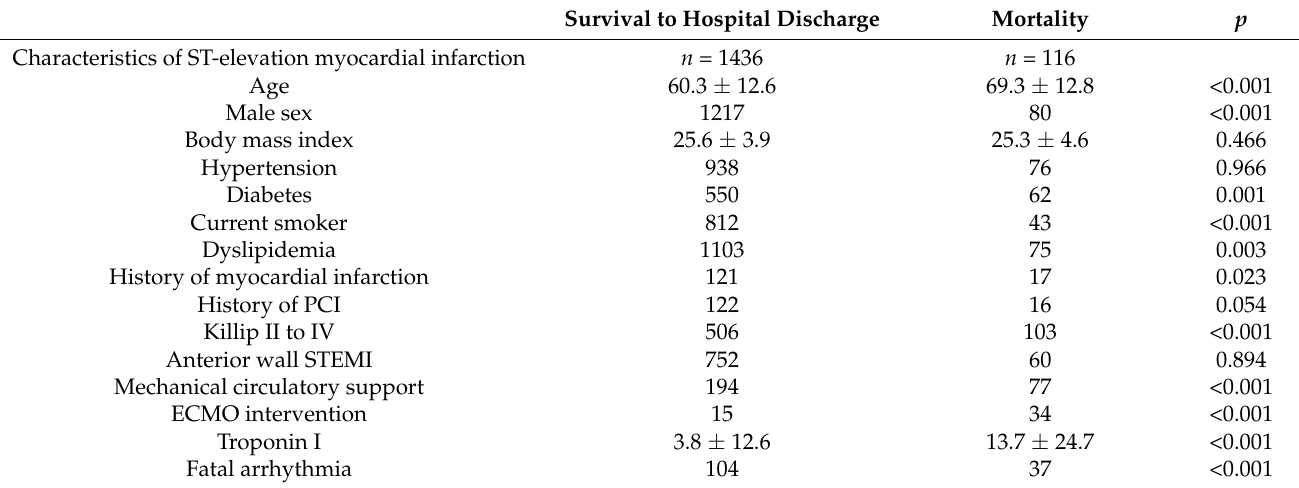
Table 1. Demographic characteristics of 1552 STEMI patients receiving